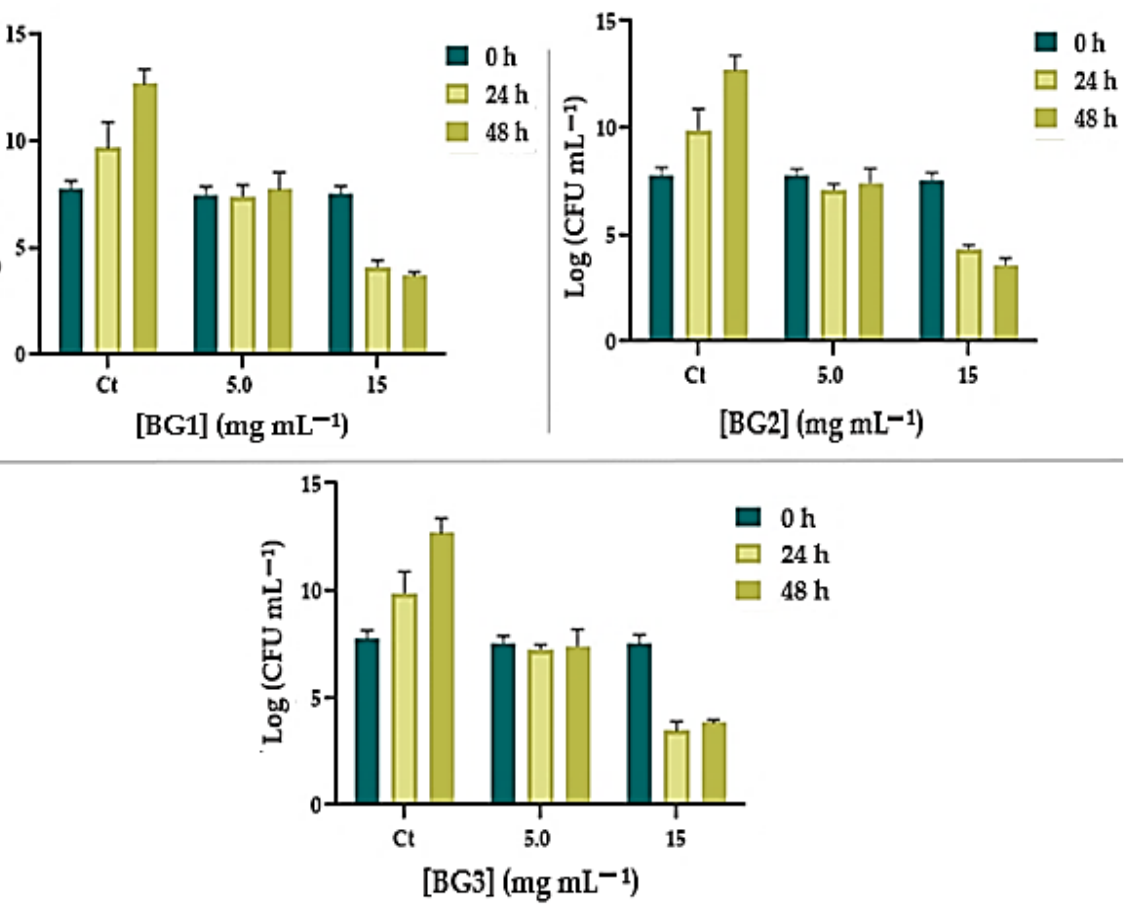
Figure 7. Growth inhibition of C. albicans ATCC 11225 in the presence of 5 and 15 mg mL −1 of BG1–3 after 24 and 48 h of incubation. The values are expressed as the means of three independent experiments; error bars indicate the standard deviation. Table 3. pH values of C. albicans and E. faecalis suspensions incubated with BG1–3 at 5